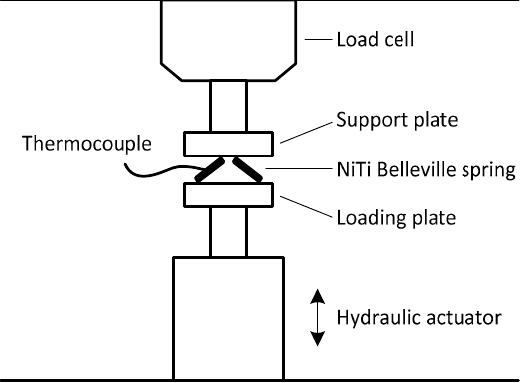
Figure 2. Experimental setup for cyclical compressive tests using MTS machine.